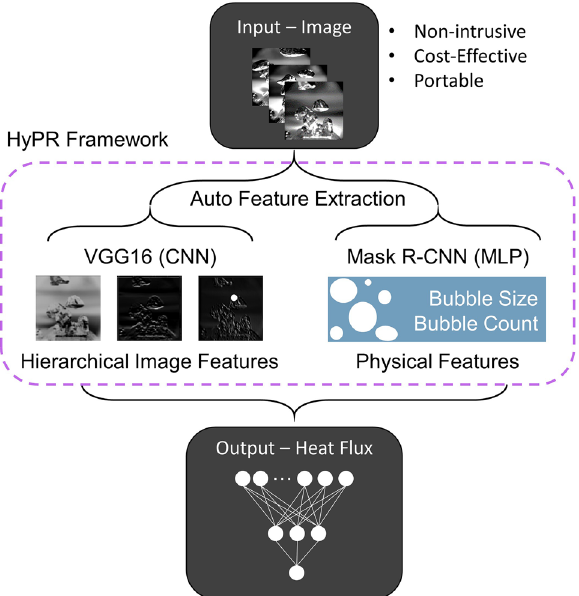
Figure 1. Physics-reinforced learning framework schematic. Remotely acquired images are provided to the framework where cutting-edge convolutional neural network (CNN) architectures and advanced object detection algorithms automatically extract features. The proposed framework learns from a hierarchy of image features as well as physical boiling patterns with the aim of predicting real-time boiling heat